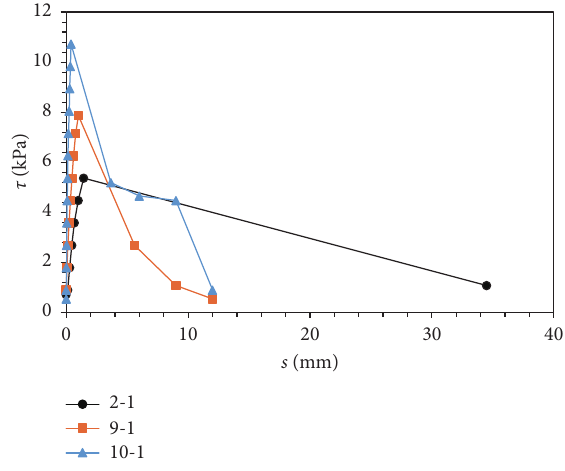
Figure 11: τ − s curves of specimens 2-1, 9-1, and